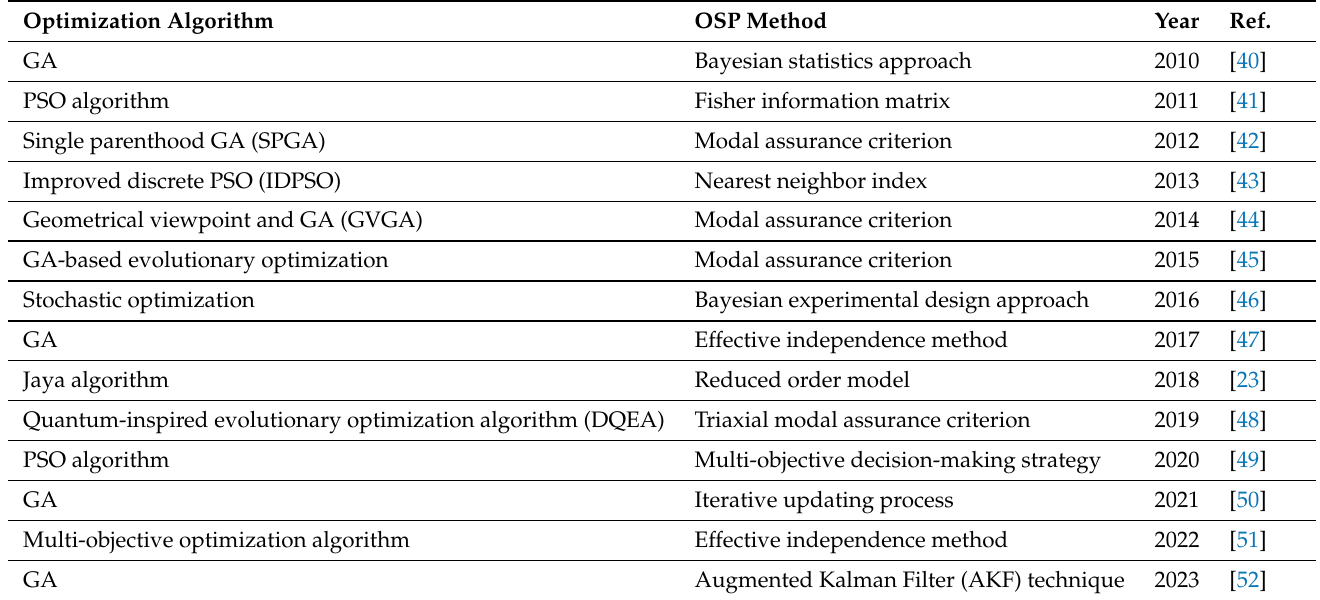
Table 3. Papers on optimization algorithms used for OSP (between 2010–2023).